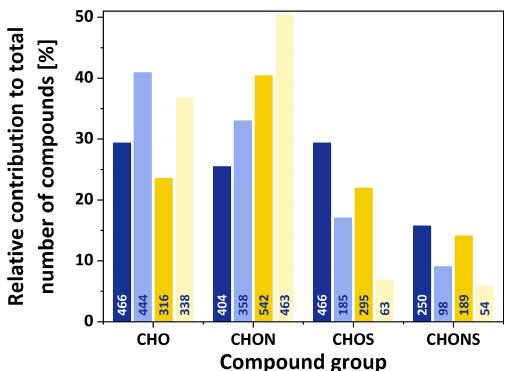
Figure 2. Bar charts showing the relative contribution of differ- ent compound groups (CHO, CHON, CHOS, CHONS) to the total number of formulae for each of the composite samples: WH (dark blue), WL (light blue), SH (dark yellow) and SL (light yellow). The numbers on the bars indicate the absolute number of formulae de- tected for the respective sample and compound class.